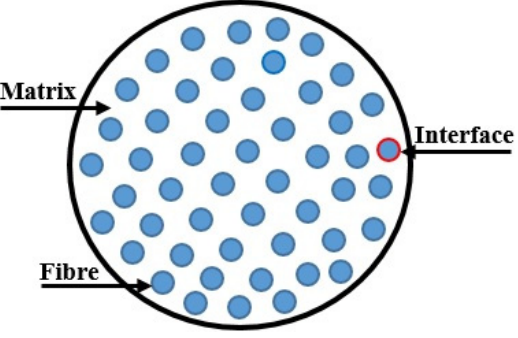
Figure 22. Fiber/matrix interface.